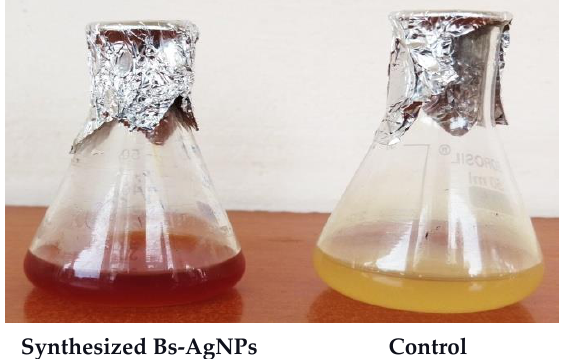
Figure 3. Bacillus mn14-mediated silver nanoparticles (Bs-AgNPs). Table 5. Characteristic features of the isolates.